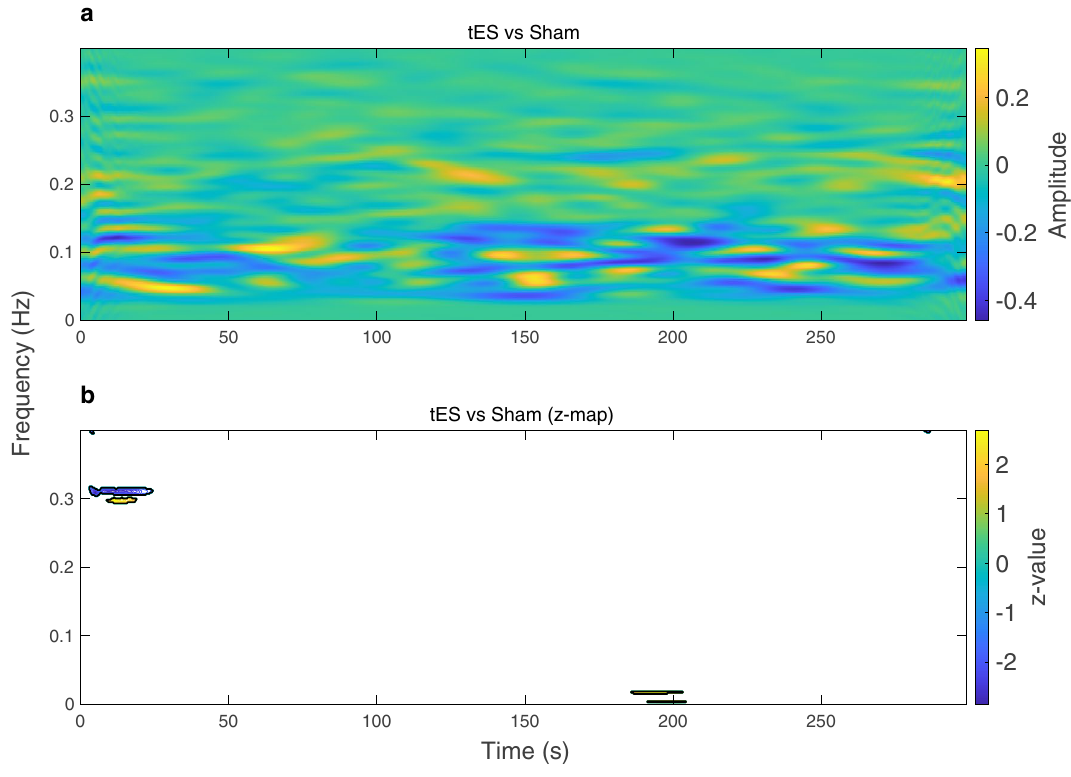
Figure 3. Time-varying power representations of heart rate variability (HRV) using the smoothed pseudo Wigner–Ville distribution (SPWVD) at the sample level. (a) Time-frequency power representation showing the power differences in tES and sham condition (after baseline subtraction within each condition). (b) Statistical z-map of the time-frequency power representation at the sample level, based on a cluster-level significance threshold p < 0.05 (two-tailed non-parametric permutation tests). Significant clusters (regions) are indicated by black contours on the statistical z-map.